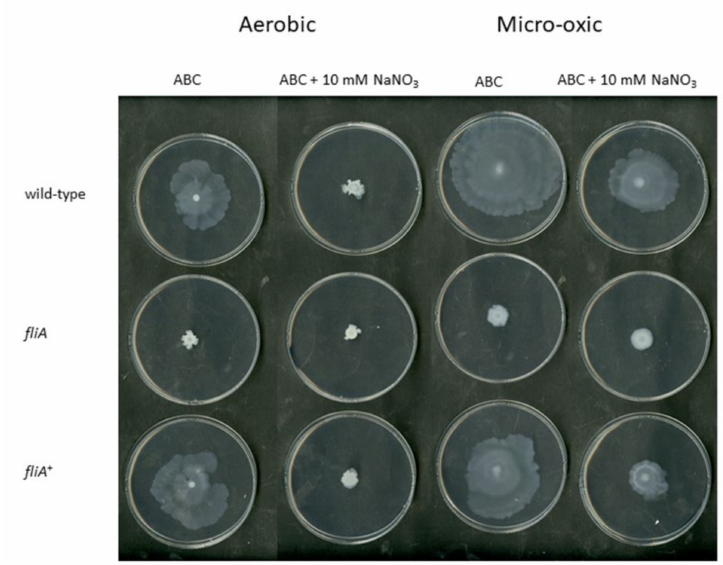
Figure 8. Swarming in aerobic and micro-oxic conditions of B. cenocepacia wild-type, a fliA mutant and the complemented strain ( fliA + ) in ABC or in ABC with 10 mM NaNO 3 after 72 h. Three biological replicates were performed, which resulted in the same phenotype as shown